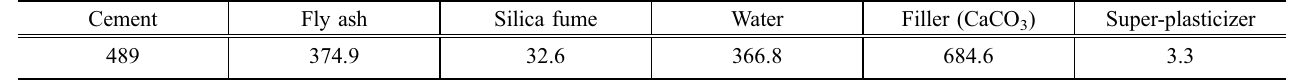
Table 2 HPFRCC mixture proportion (unit: kg/m 3